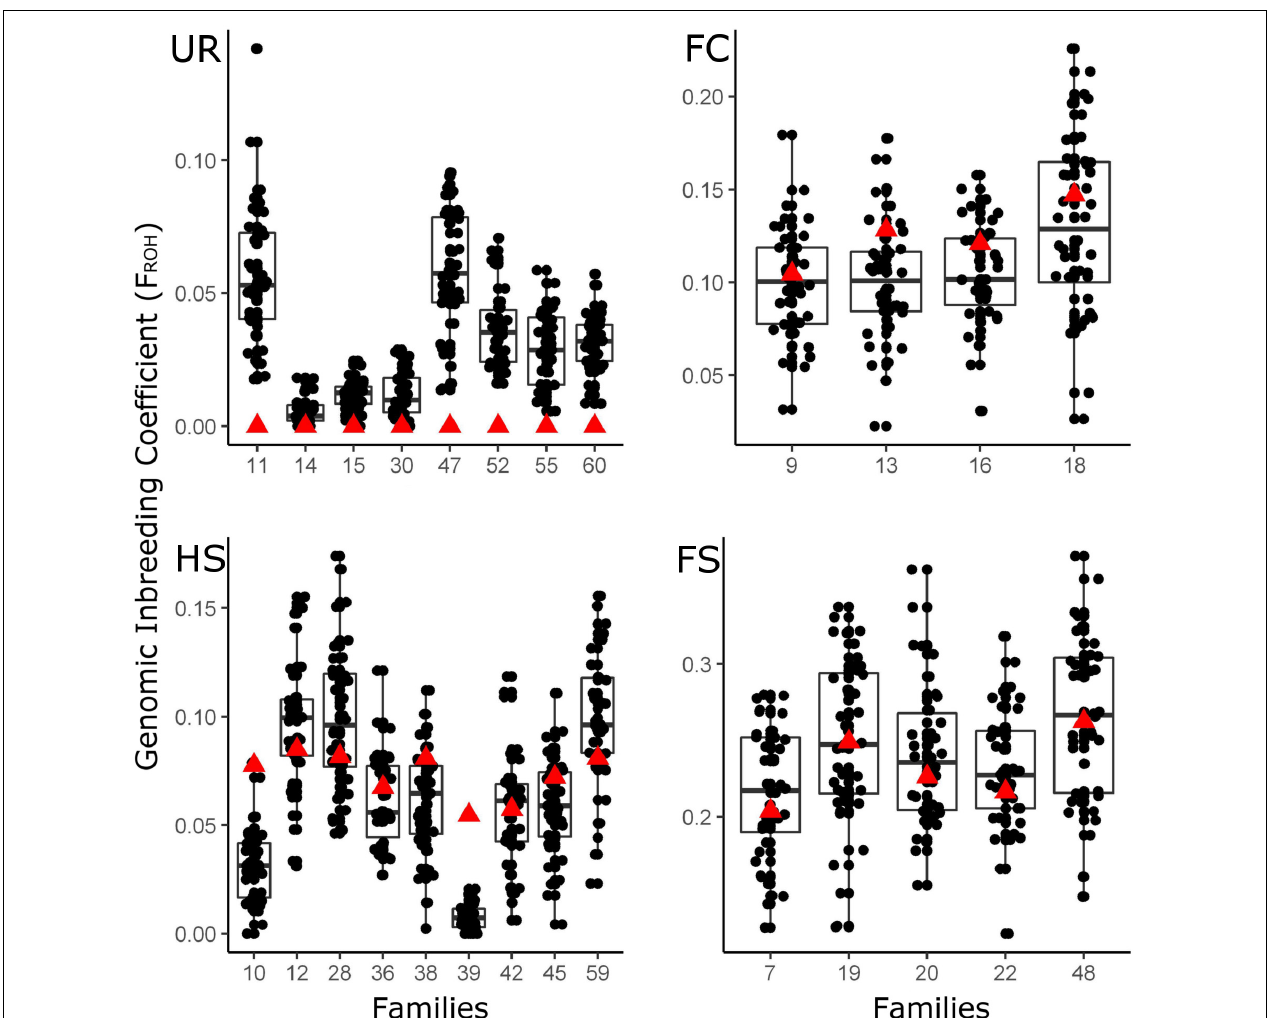
FIGURE 1 | Genomic inbreeding estimated through ROH (F ROH ). F ROH ( y -axis) was obtained using a 1 Mb ROH cut-off for each family. Family codes are presented in x -axis and grouped by their parental kinship coefficients θ IBD as follows: UR; unrelated (0.0076 < θ IBD ), FC; first cousin (0.038 < θ IBD < 0.0937), HS; half-sibling (0.0937 < θ IBD < 0.1872) and FS; full-sibling ( θ IBD > 0.1872). Red triangles represent the θ IBD of each family’s parents.